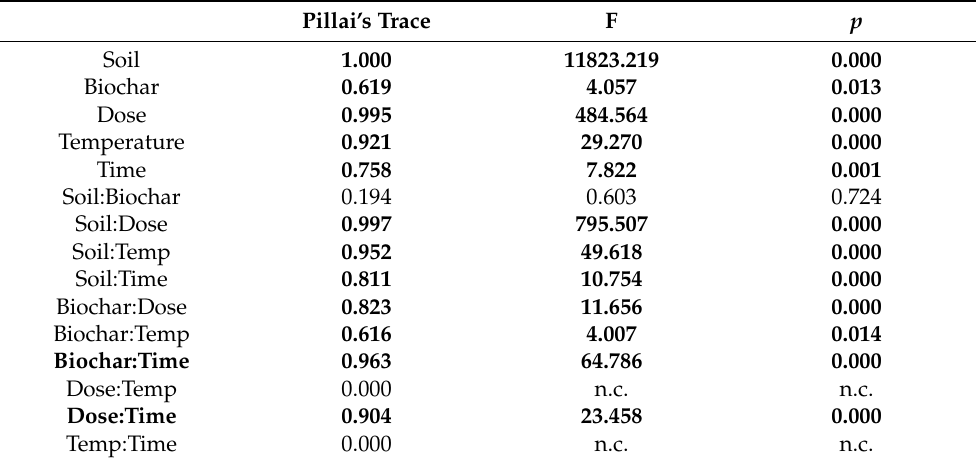
Table 5. MANOVA results for variables affecting CaCl 2 -extractable trace